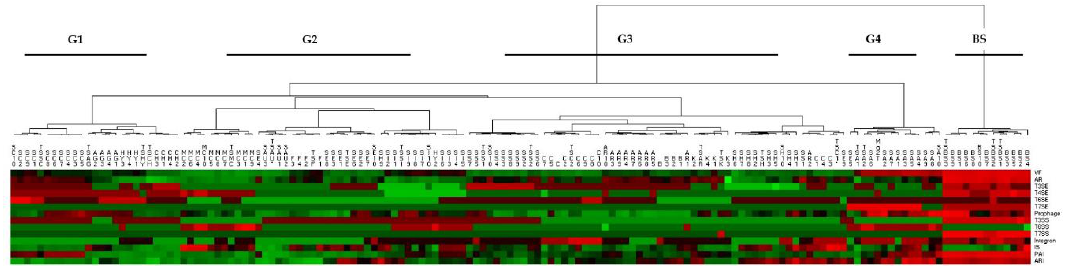
Figure 3. Heatmap of virulence elements detected in the dataset. Clustering was based on comparative quantitative analysis of similar virulence elements identified within 148 genomes of the dataset. The different groups represent five different sets of virulence profiles. Color scale corresponds to the number of predicted genes associated to specific virulence element, from green (lowest) to red (highest). Note: Abbreviations used are relative to single strains (see Table S2 for details).